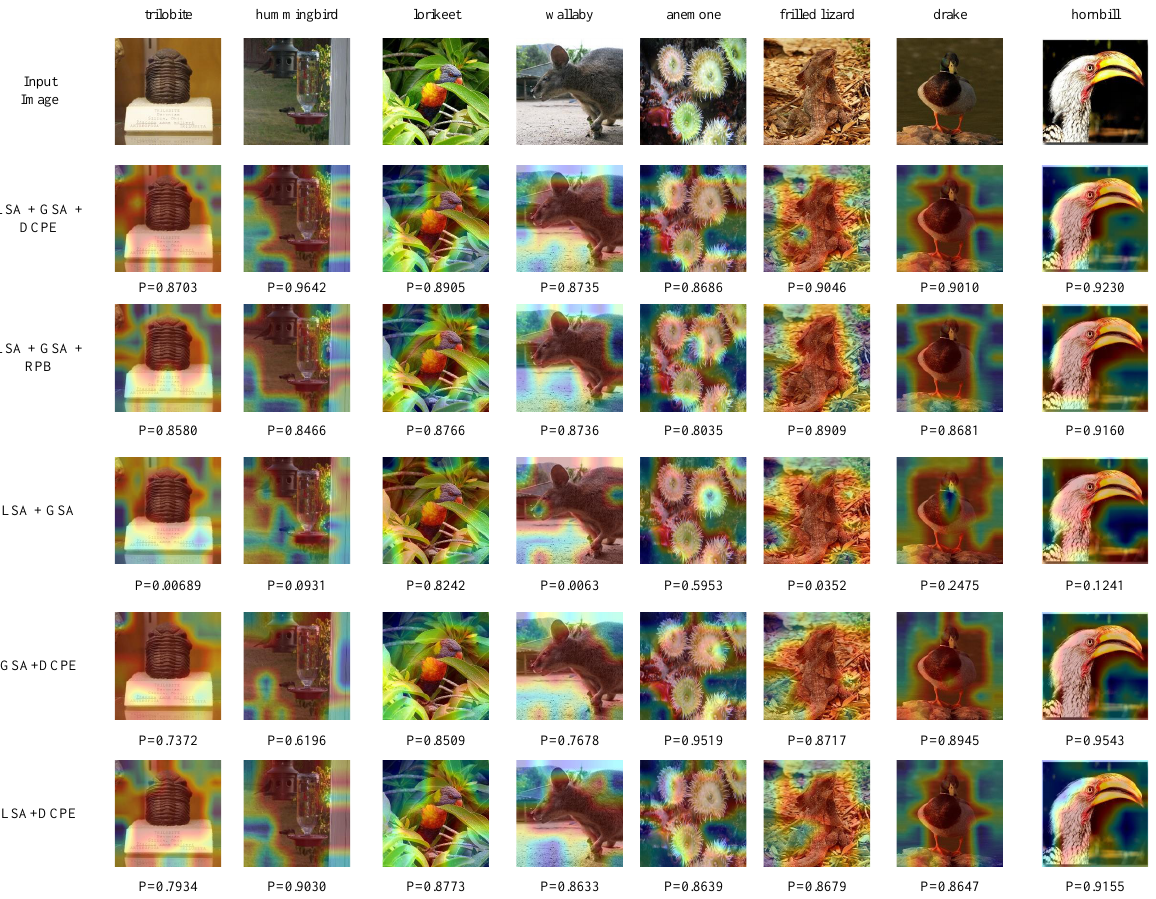
Figure A2. Visualization of heat map calculated by Grad-CAM. We compare the visualization results of our network with different self-attention modules and position encoding modes. The grad-CAM visualization is calculated for the last stage outputs. The ground-truth label is shown on the top of each input image and P denotes the softmax score of each network for the ground-truth